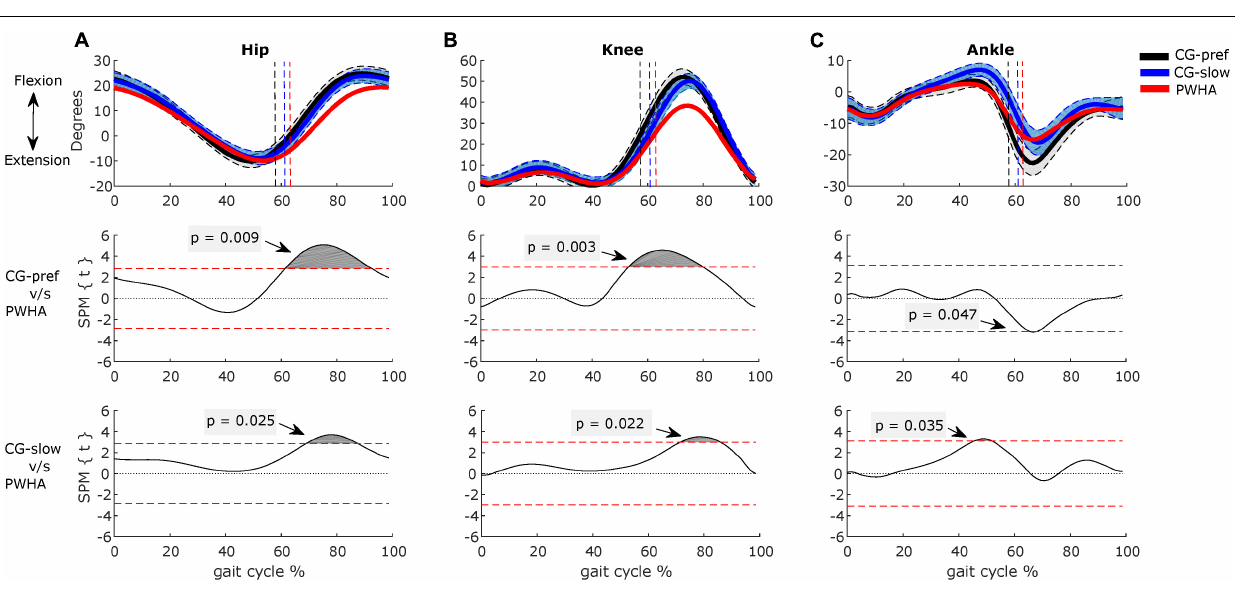
Frontiers in Physiology |